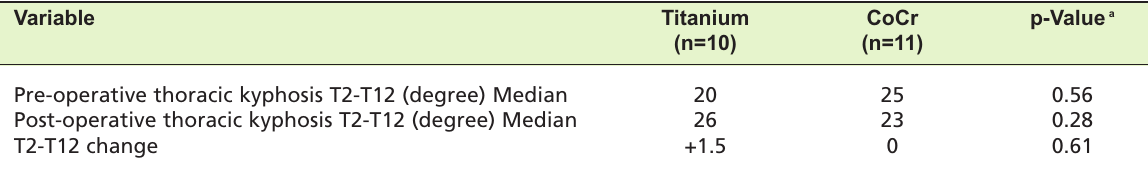
Comparison of thoracic kyphosis between titanium and Table IV: